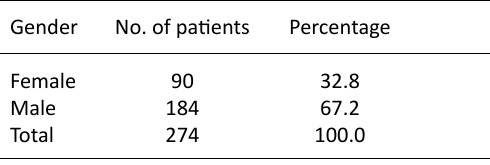
Table 2. Gender wise distribution